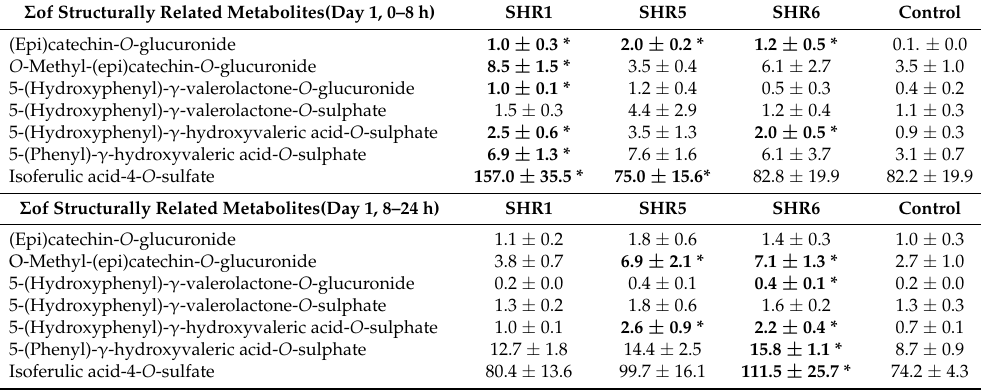
grape pomace extracts. Data are expressed as nmol ± SD.